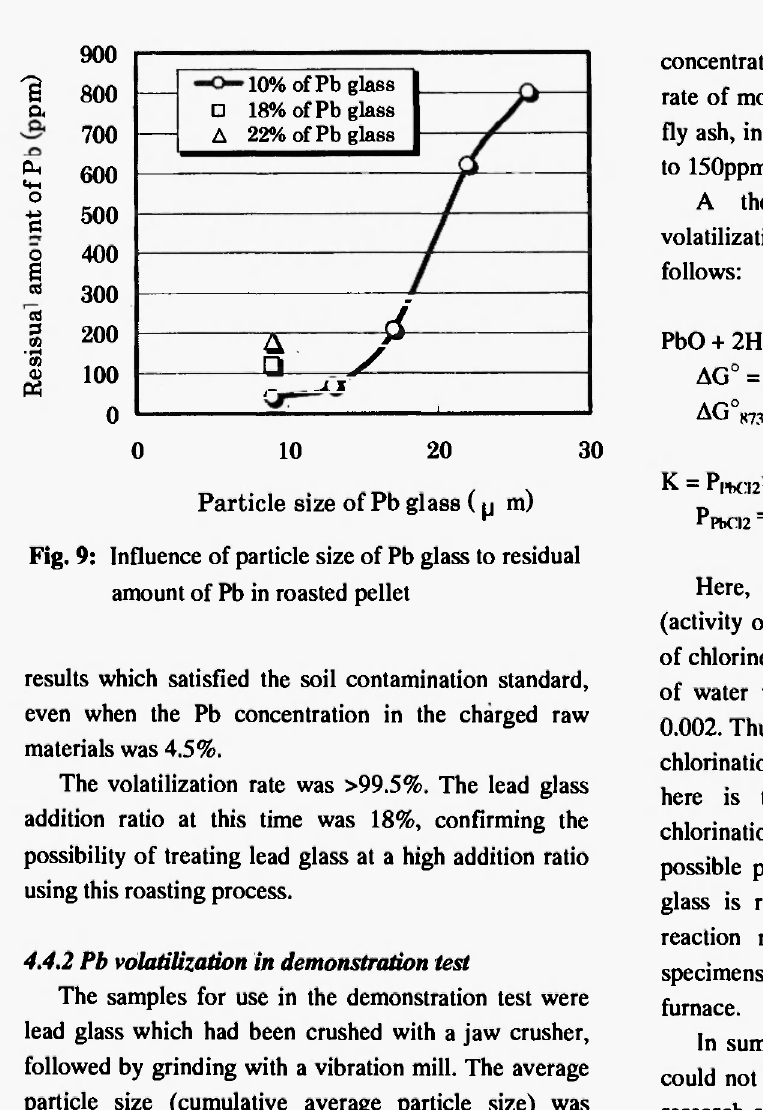
results which satisfied the soil contamination standard, even when the Pb concentration in the charged raw materials was 4.5%.